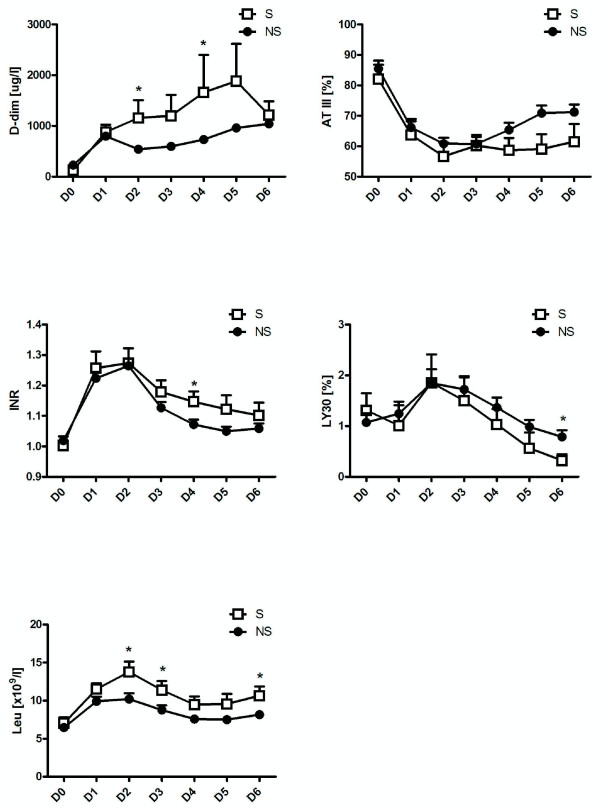
Mean postoperative changes in serum D-dimers (A); ATIII (B); INR (C); LY-30 (D); and leucocytes (E). Changes in concentrations of haematological and coagulation factors in the septic (S) and non-septic (NS) groups from day of surgery (D0) to Day 6 after surgery (D6). Suprisingly, TEG is not an early predictor of sepsis development. * indicates p < 0.05.